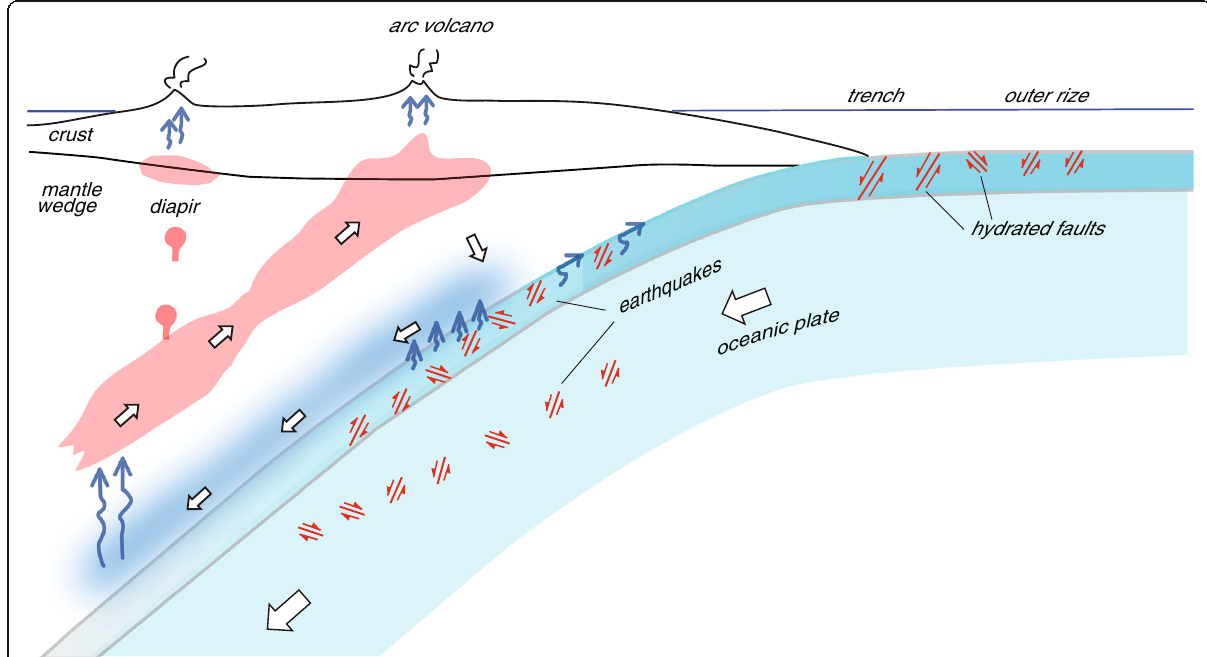
Fig. 2 Schematic diagram showing normal faults in the trench – outer rise, intermediate-depth intraslab earthquakes, and arc magmatism. Estimated transportation paths of H 2 O from the subducting slab to the arc crust are indicated by blue arrows (Hasegawa and Nakajima,